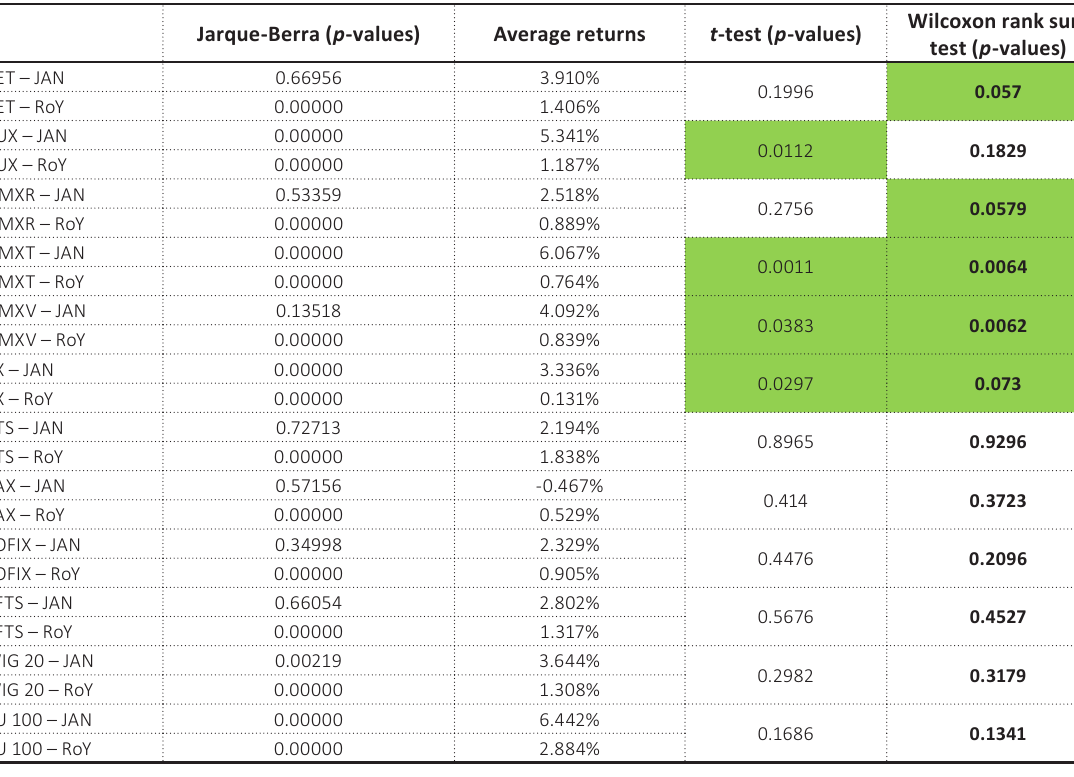
Table 3. Average returns by